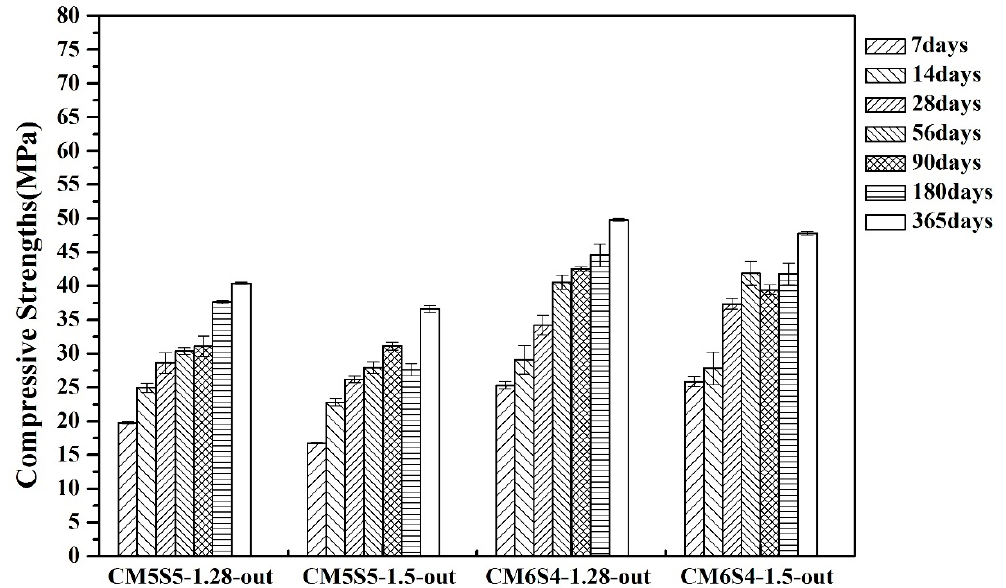
Figure 1. E ff ect of the powder ratio and SiO 2 / Na 2 O molar ratio on the compressive strength when Figure 1. Effect of the powder ratio and SiO 2 /Na 2 O molar ratio on the compressive strength when curing in an uncontrolled outdoor curing in an uncontrolled outdoor environment.